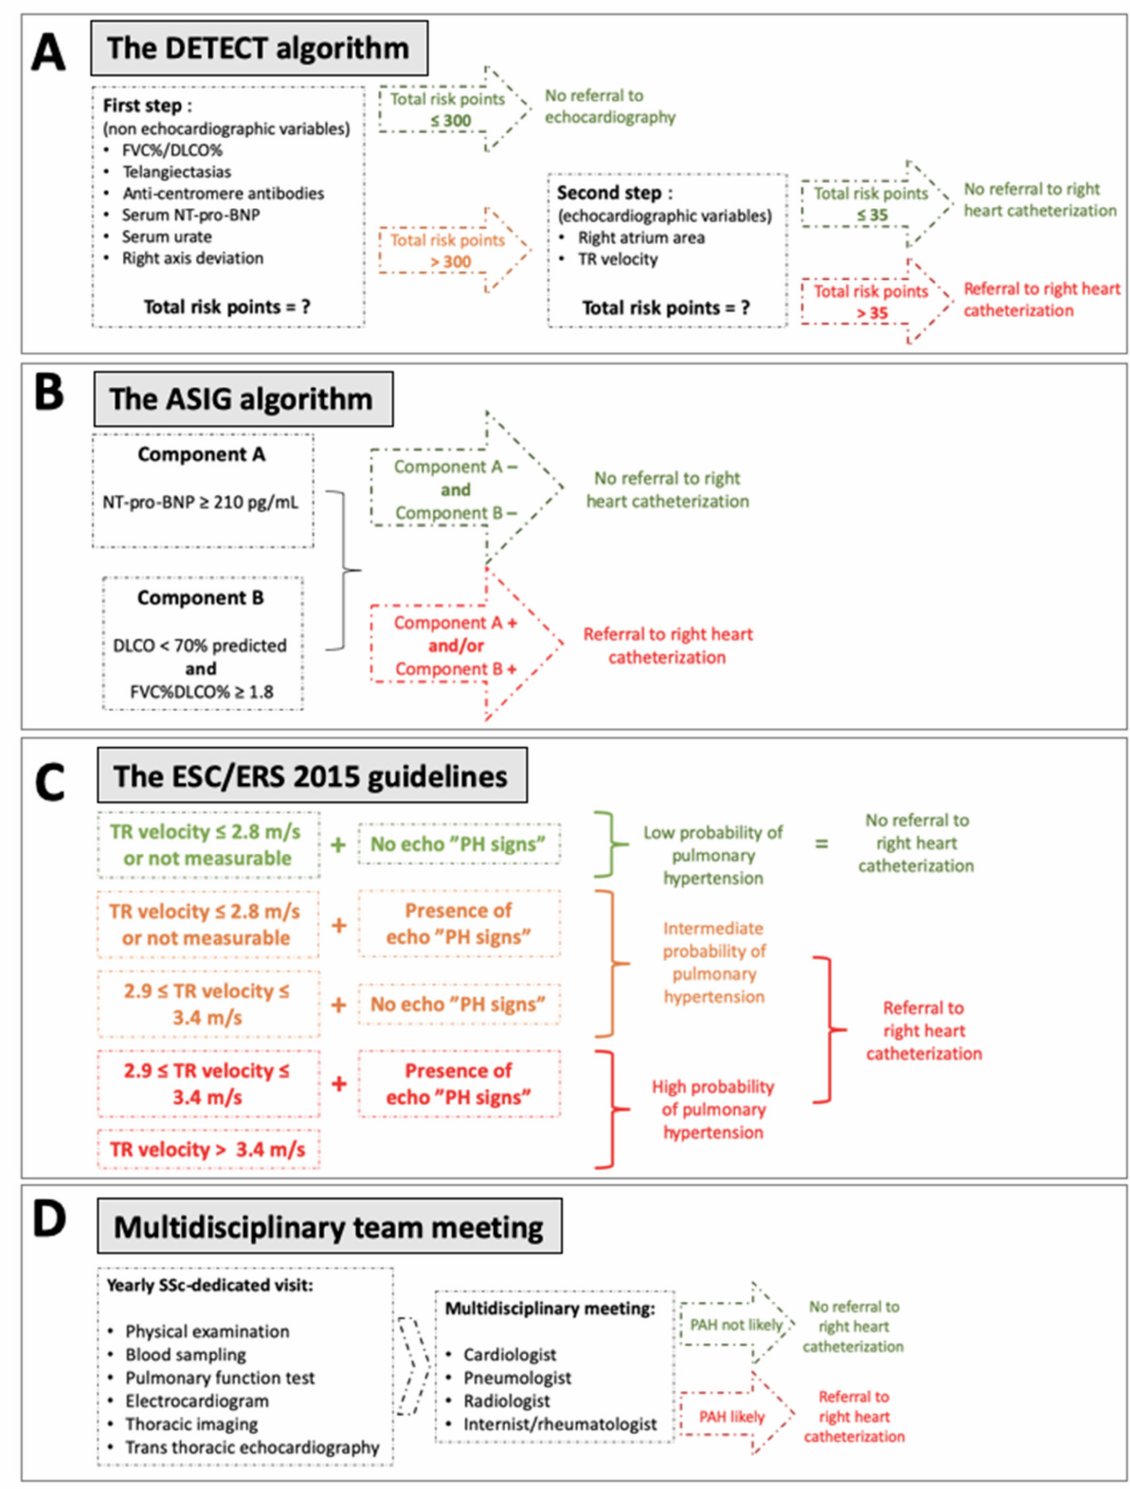
Figure 1. Description of the four different screening situations compared. ( A ) DETECT algorithm; ( B ) ASIG algorithm; ( C ) ESC/ERS 2015 guidelines; ( D ) Multidisciplinary team meeting. DLCO: diffusing capacity for carbon monoxide; FVC: forced vital capacity; NT-pro-BNP: N-terminal pro-B-type natriuretic peptide; PAH: pulmonary arterial hypertension; PH: pulmonary hypertension; TR: tricuspid